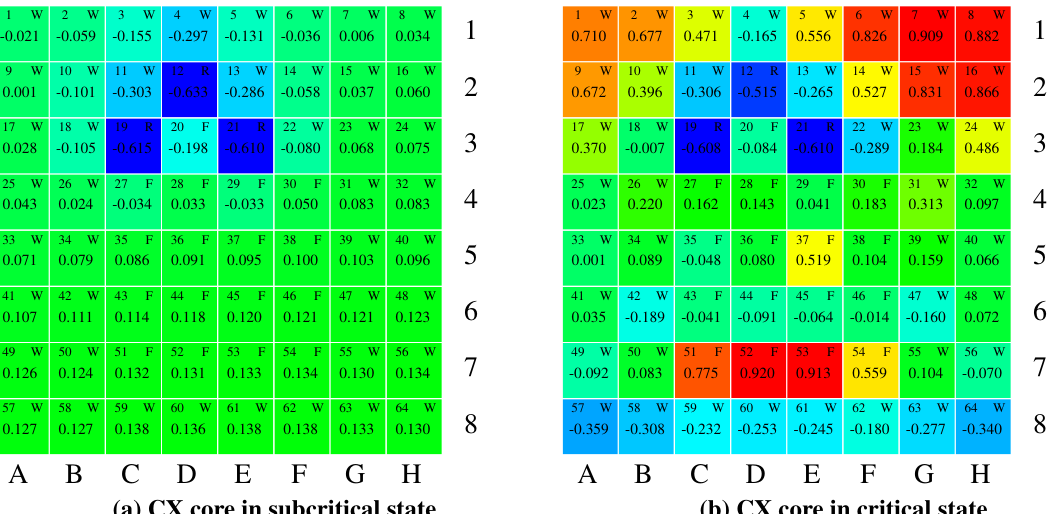
Figure 5: Relative change of thermal neutron flux peaking in CX core caused by presence of stainless steel reflectors, F indicates fuel element, W water, and R reflector